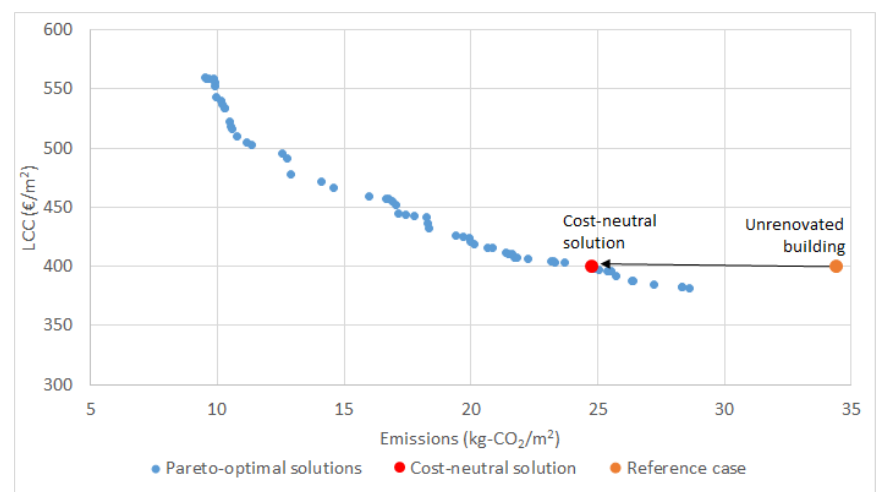
Figure 3. Selection of cases for this study. The cost-neutral cases were chosen from the Pareto fronts generated in previous studies.